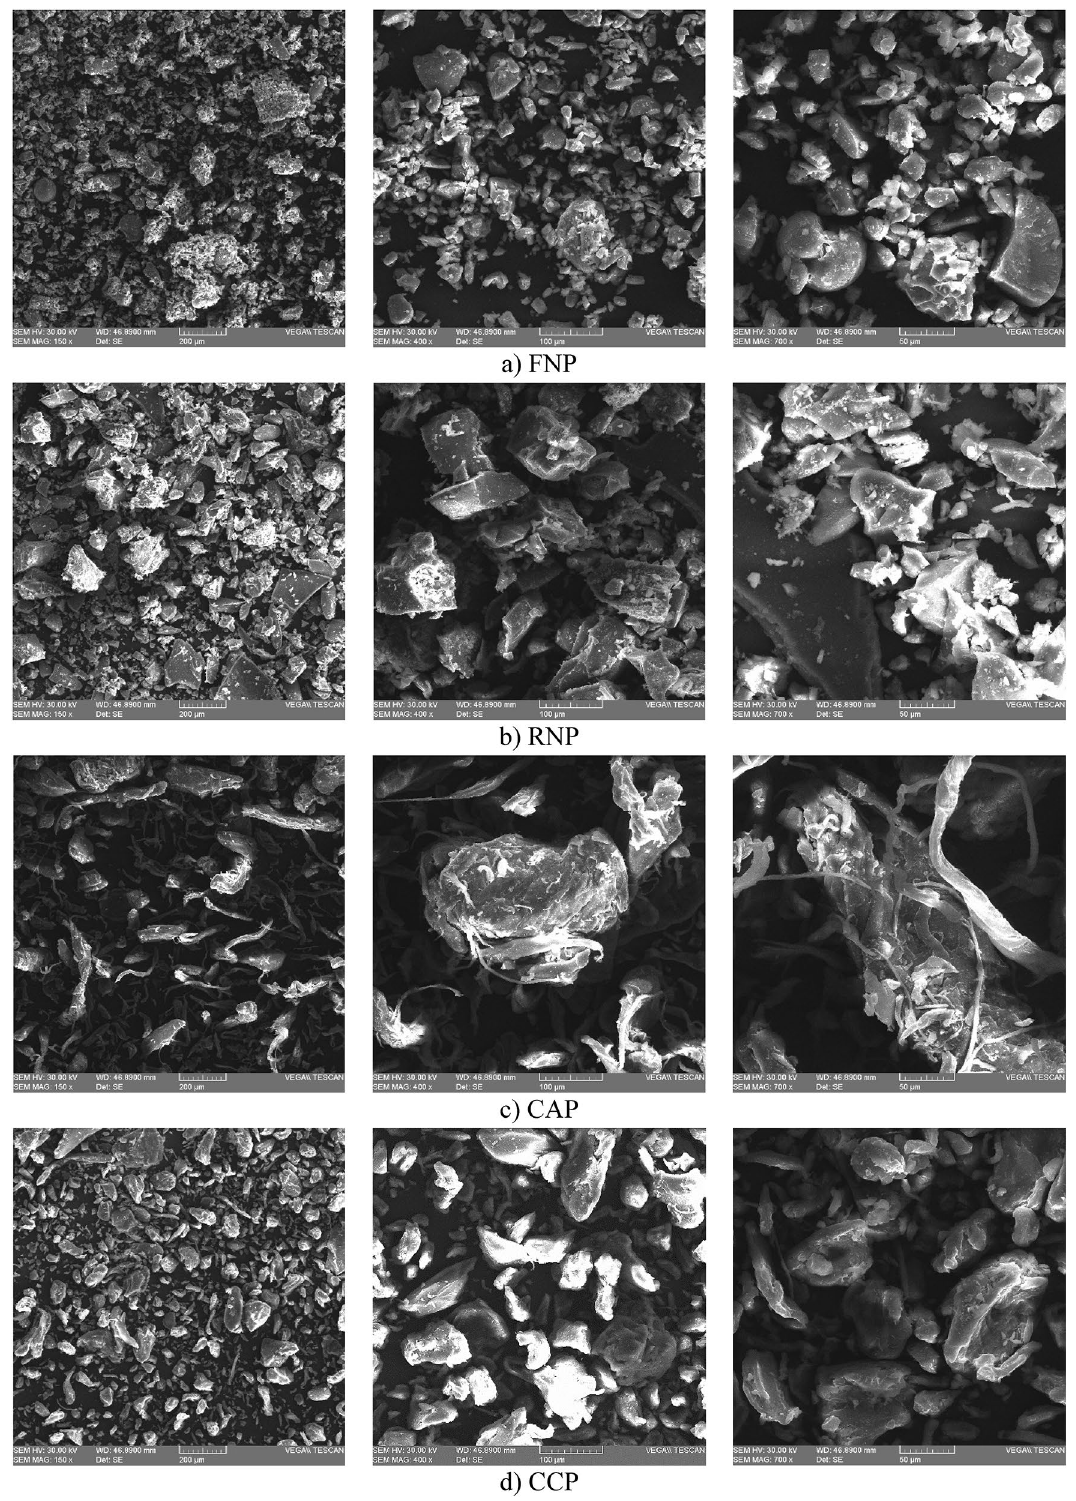
Figure 8. SEM images of pectin solutions: Fetească Neagră pectin (FNP), Rară Neagră pectin (RNP), commercial apple and citrus pectin (CAP and